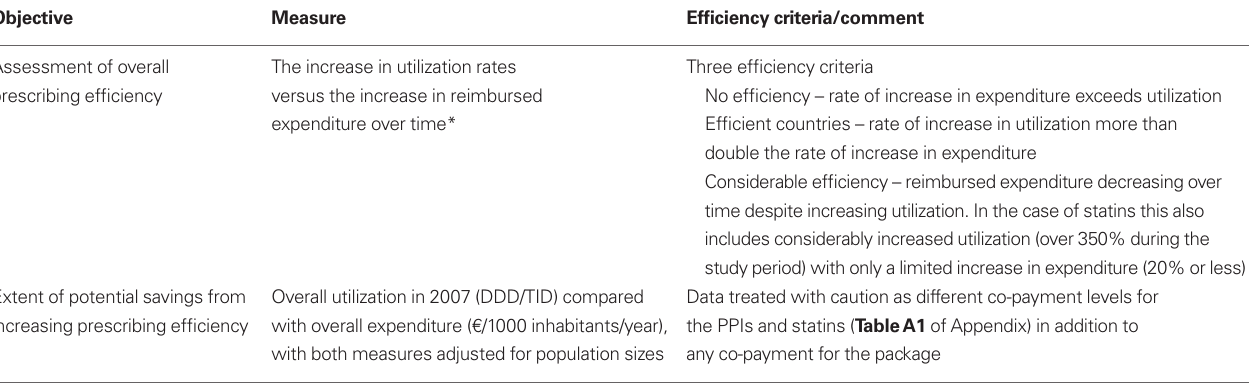
Table 3 | Principal measures used to evaluate changes in prescribing efficiency for both the PPIs and statins during the study years as well as categorize countries.